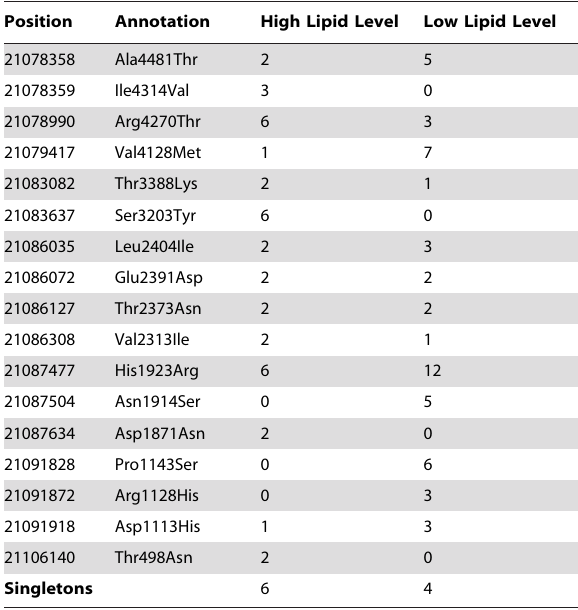
Figure 2. The distribution of recurrent, low frequency non- synonymous variants. In (A) 100 high and 100 low extremes of triglyceride levels drawn from the Malmo Diet and Cancer Study – Cardiovascular Arm in APOB and (B) 350 cases of Crohn’s disease and 350 controls collected by the NIDDK IBD Genetics Consortium in NOD2 , identified from pooled data and then individually genotyped. The background (gray) represents the binomial probability distribution while the foreground (red points) shows observed data from NOD2 and APOB sequencing, in which, for example, APOB (A) the n=3 row indicates three observed variants, one seen in 3 cases and 0 controls, one seen in 2 cases and 1 control, and one seen in 0 cases and 3 controls.